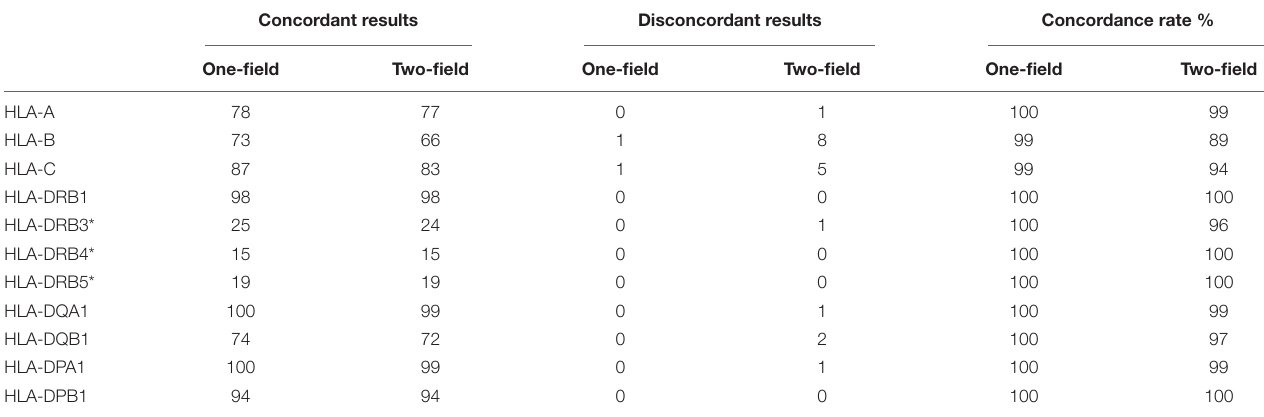
TABLE 3 | Concordance of HLA typing results between ONT RNA-Seq and Luminex SSO-PCR. Concordant results Disconcordant results Concordance rate % One-field Two-field One-field Two-field One-field